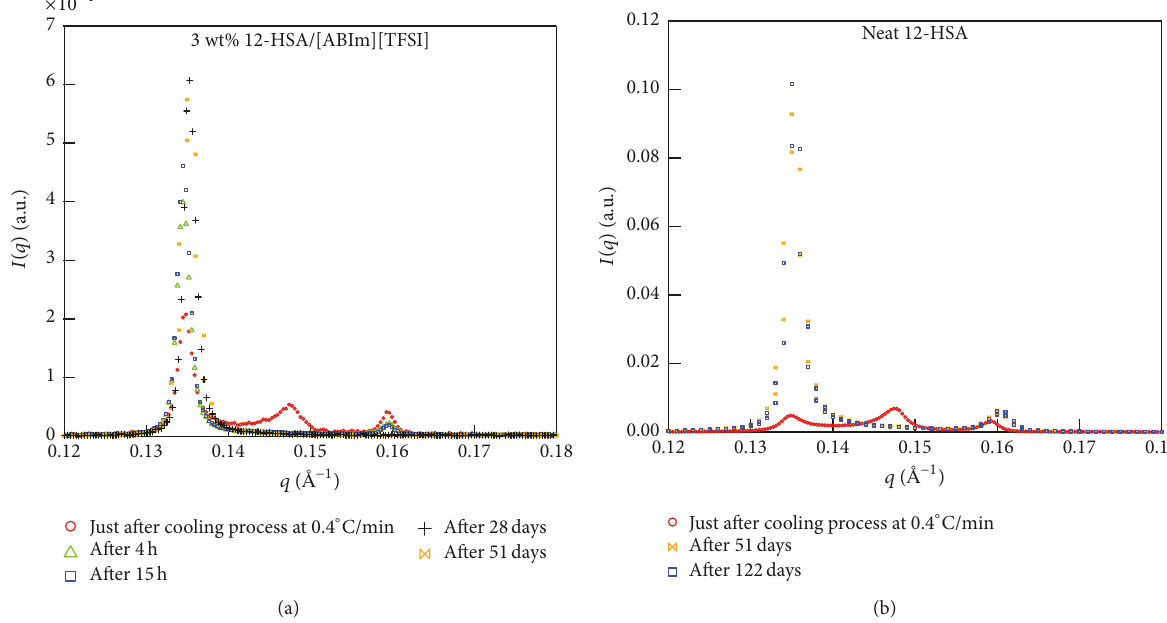
Figure 8: Time series of SAXS profiles of 3 wt% 12-HSA/[ABIm][TFSI] gel (a) and a neat 12-HSA (b) placed at the ambient temperature after the cooling process at a rate of 0.4 ∘ C/min.